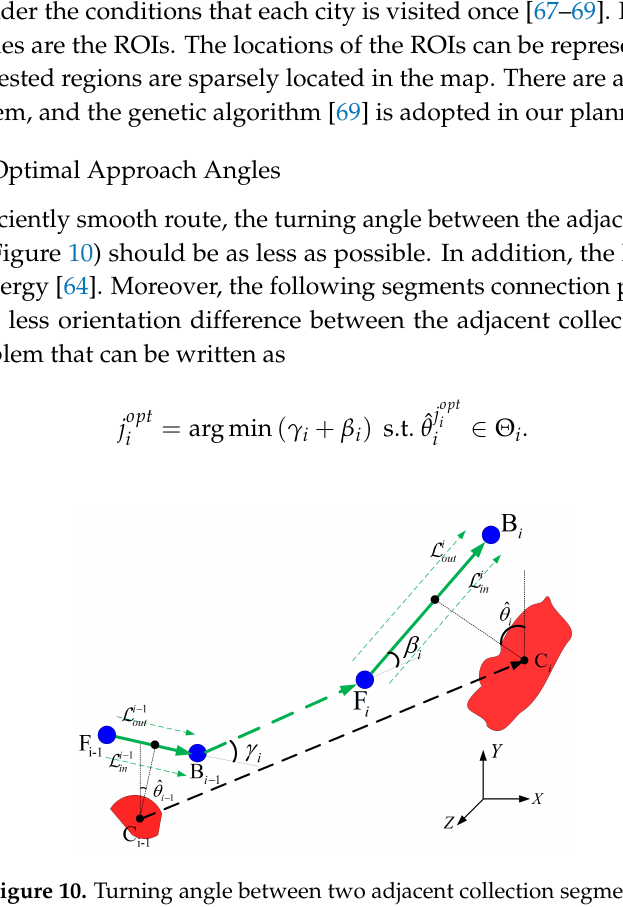
Figure 10. Turning angle between two adjacent collection